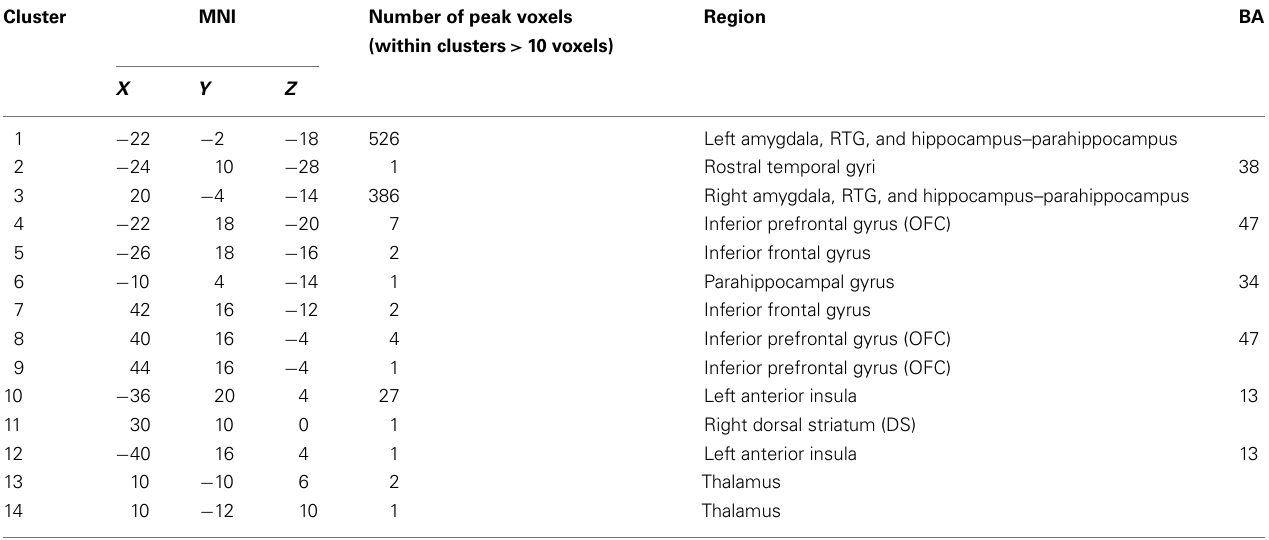
FIGURE 1 |Aversion network in humans. Results of meta-analysis for human aversion-related studies.Yellow represents peak voxels in a local neighborhood, blue represents significant extended clusters. All results are family wise error rate whole-brain corrected at p < 0.05.The numbers below each axial section represent the Z coordinate. Note that each area is noted only once unilaterally for clarity. See Tables 1 and 2 for related